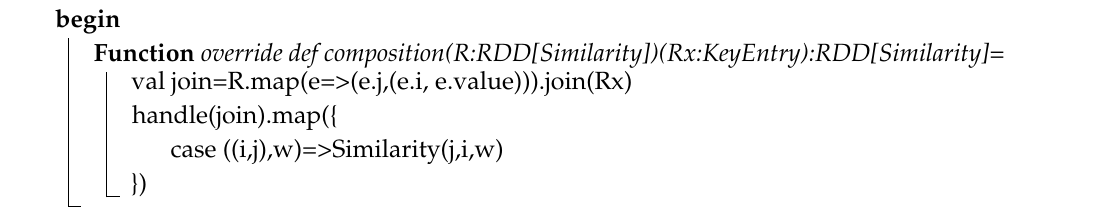
Algorithm 5: The overridden composition method in the SiMatrix